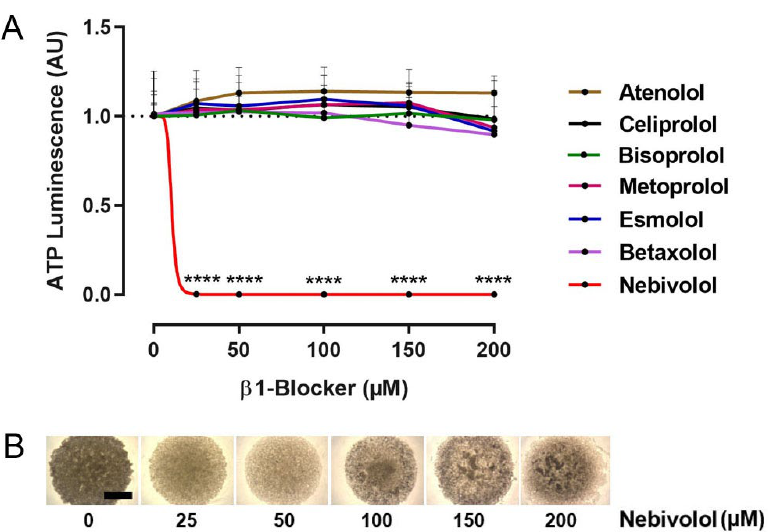
Figure 1. Screening for ß1-selective blockers with anti-tumor activity in 3D tumor spheroids. ( A ) Concentration-response curves of tumor spheroids generated from a Mel270 cell line. Spheroid vi-